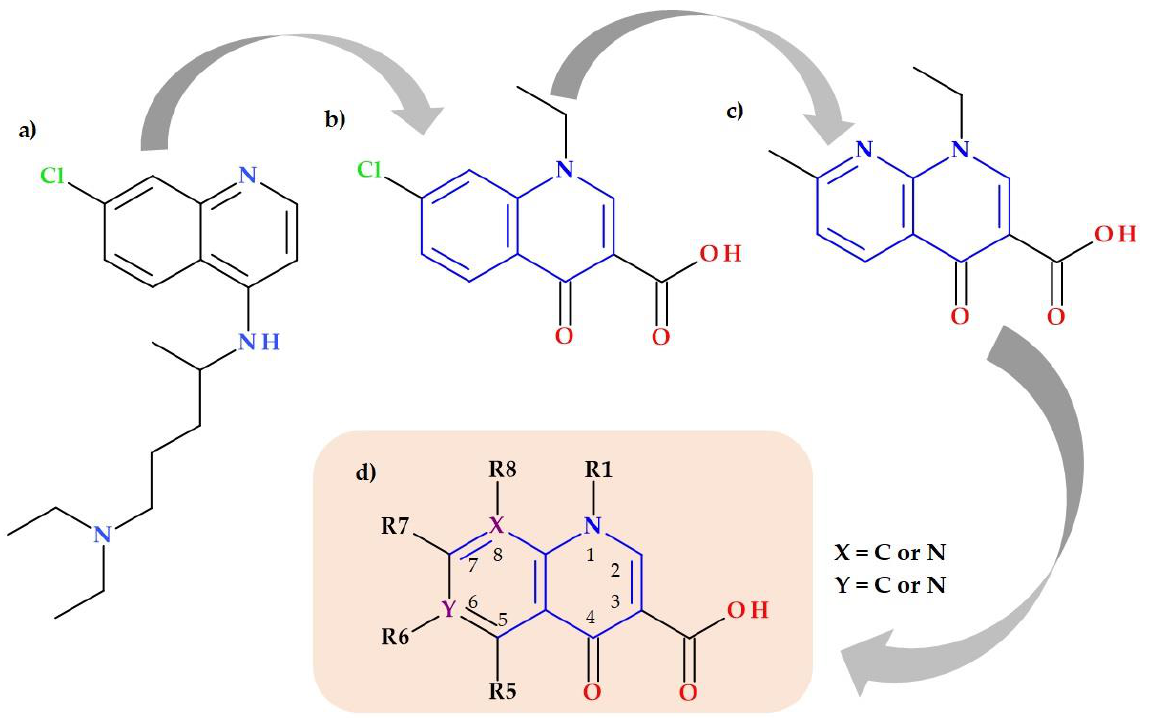
Figure 1. Key compounds in the discovery of QNs: ( a ) chloroquine, ( b ) 7-chloro-l-ethyl-l,4-dihydro-4-oxoquinoline-3-carboxylic acid, ( c ) nalidixic acid, and ( d ) general structure of QNs (QNs—antibacterial quinolones).